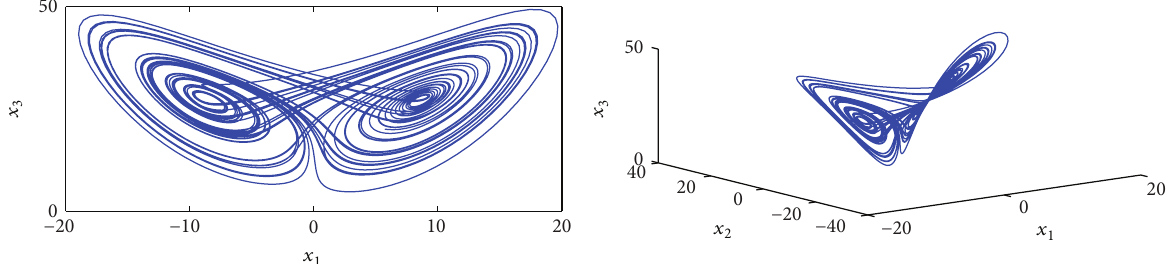
Figure 1: The attractor of fractional-order Lorenz system (12) for 𝑞 = 1.05